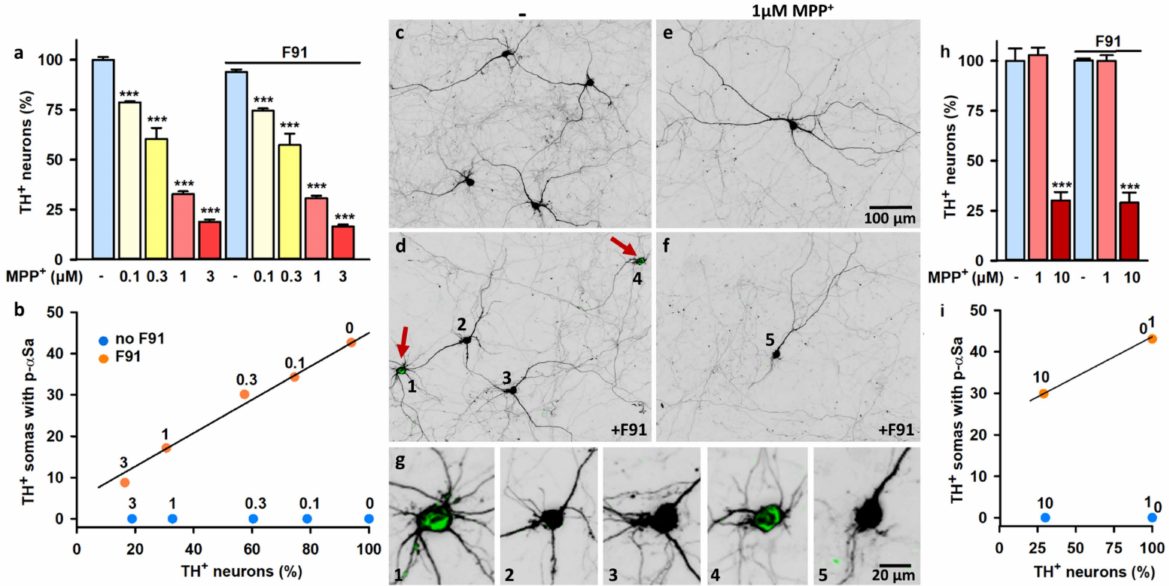
Figure 7. Impact of mitochondrial complex I inhibition on α S seeded aggregation in midbrain DA neurons in culture. ( a ) Survival of TH + neurons in DIV 21 midbrain cultures challenged or not challenged with MPP + (0.1–3 µ M) between DIV 5–7 and then exposed to 0.5 µ M F91 at DIV 7. Data are means ± SEM ( n = 3–11). *** p < 0.001 vs. controls. One-way ANOVA followed by Dunnett’s test. ( b ) Survival of TH + neurons plotted against the percentage of these neurons with somal α Sa in DIV 21 midbrain cultures submitted to the same treatments as in ( a ) ( n = 3–11). ( c – f ) Low magnification images from DIV 21 midbrain cultures challenged or not challenged with 1 µ M MPP + between DIV 5–7 and then exposed or not exposed to 0.5 µ M F91 at DIV 7. Red arrows point to TH + neurons with somal aggregates (green). ( g ) Enlarged version of TH + somas annotated (1–5) in low-magnification microphotographs. The green signal corresponds to p- α Sa. Note the absence of somal aggregates in the TH + neuron surviving the MPP + challenge. ( h ) Survival of TH + neurons in DIV 21 midbrain cultures exposed or not exposed to 0.5 µ M F91 at DIV 7 and then challenged or not challenged with MPP + (1; 10 µ M) between DIV 14–16. Data are means ± SEM ( n = 4–6). *** p < 0.001 vs. controls. One- way ANOVA followed by Dunnett’s test. ( i ) Survival of TH + neurons plotted against the percentage of these neurons with somal α Sa in DIV 21 midbrain cultures submitted to the same treatments as in ( h ) ( n = 4–6). MPP + concentrations are indicated in micromolar units above circles in ( b , i